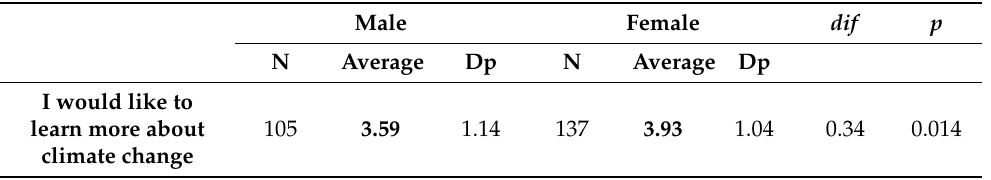
Table 5. Significance value of the comparison of the degree of agreement with statements on climate change according to gender.